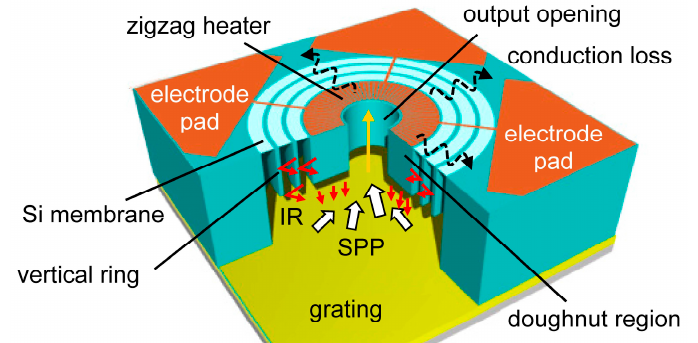
Figure 3. Schematic drawing of the microheater on the grating. There is alignment tolerance between the microheater and the underlying grating since the grating is uniform.